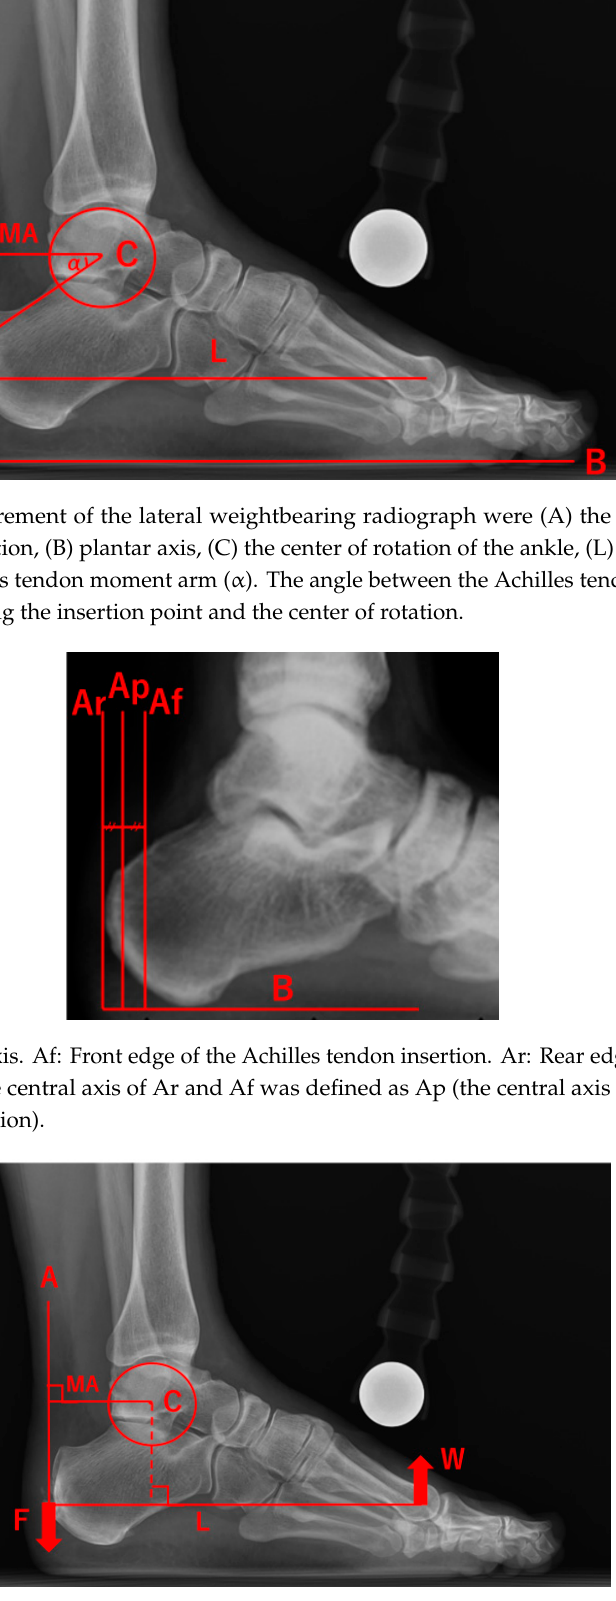
Figure 5. (A) The centerline of the Achilles tendon insertion, (C) the center of rotation of the ankle, (L) the length of the sole, and (MA) the Achilles tendon moment arm. (F) Traction force of the Achilles tendon. (W) Reaction force by body weight. We calculated F using principle of